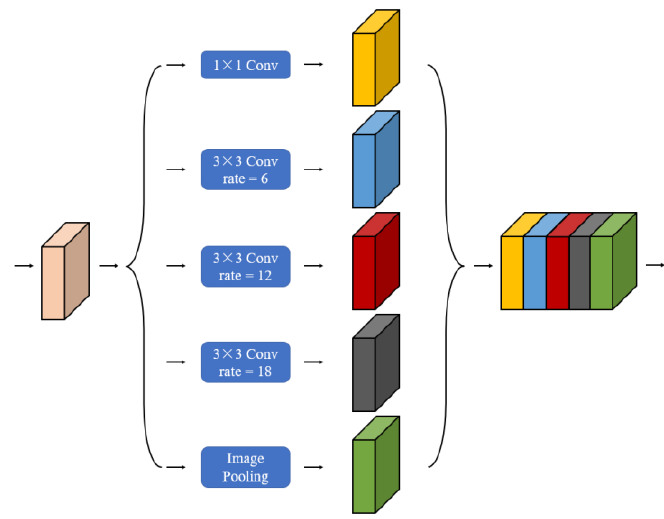
Figure 3. The structure of atrous spatial pyramid